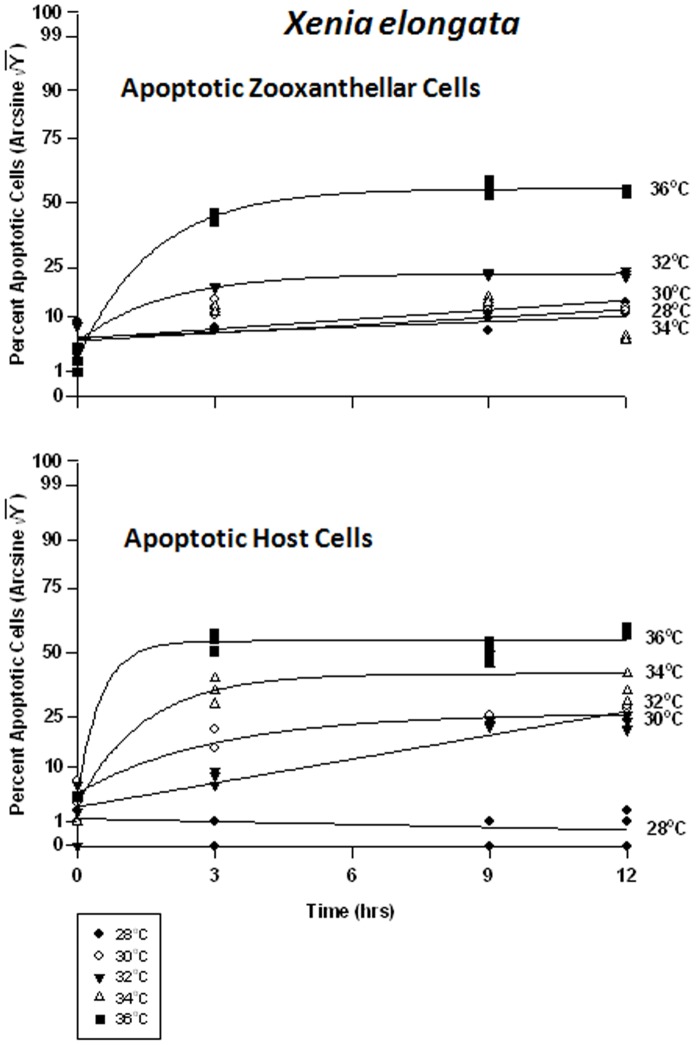
Effects of seawater temperature on percent apoptotic endosymbiotic Symbiodinium and host coral Xenia elongata cells.In-hospite, collected over a12 h period. Corals exposed to 28 to 36°C treatments. Data transformed by arcsine for normalization purposes. • = 28°C; ○ = 30°C;▾ = 32°C; Δ = 34°C; ▪ = 36°C. Zooxanthellae: Significant positive linear regression at 28°C (p<0.05; Y = 0.601X +13.028). Significant non-linear increase in response at 30°C and 34°C (p<0.001); linear trend shown to facilitate comparison (Y = 0.748X +13.474, and Y = 0.415X +13.746, respectively). Significant non-linear responses at 32°C and 36°C (p<0.001; Y = 12.646+16.134*(1−e[−0.530X]), and Y = 8.464X +40.198*e[−0.608], respectively). Host Cells: No significant linear regression at 28°C (p>0.05); i.e., regression coefficient not significantly different than “0″. Significant non-linear responses at 30°C, 34°C, and 36°C (p<0.001; Y = 9.592+30.720*e[−0.686X], Y = 11.537+36.441*e[−1.955X], and Y = 12.327+18.706*e[−0.331X], respectively). Significant positive linear response at 32°C (p<0.05; Y = 1.864X +9.113).